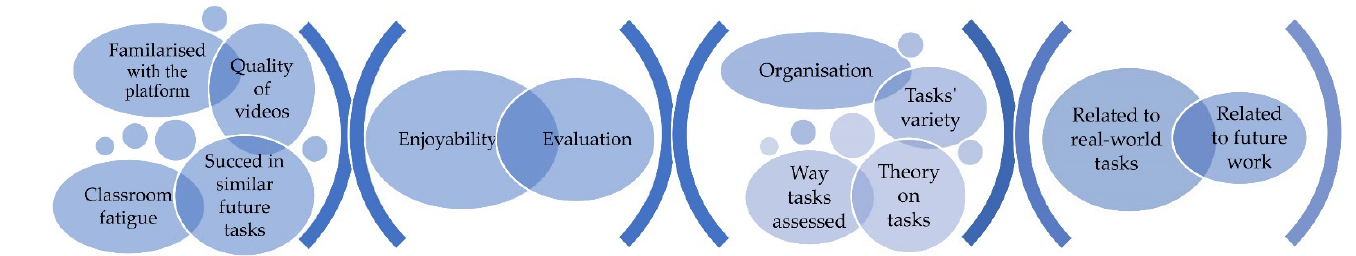
Figure 6. Organogram of the correlation among nominal variables.